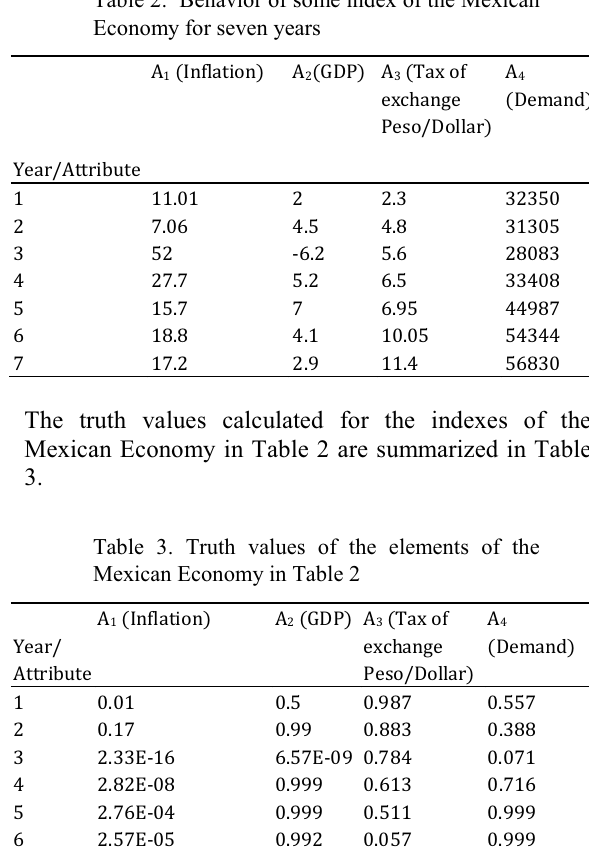
Table 2. Behavior of some index of the Mexican